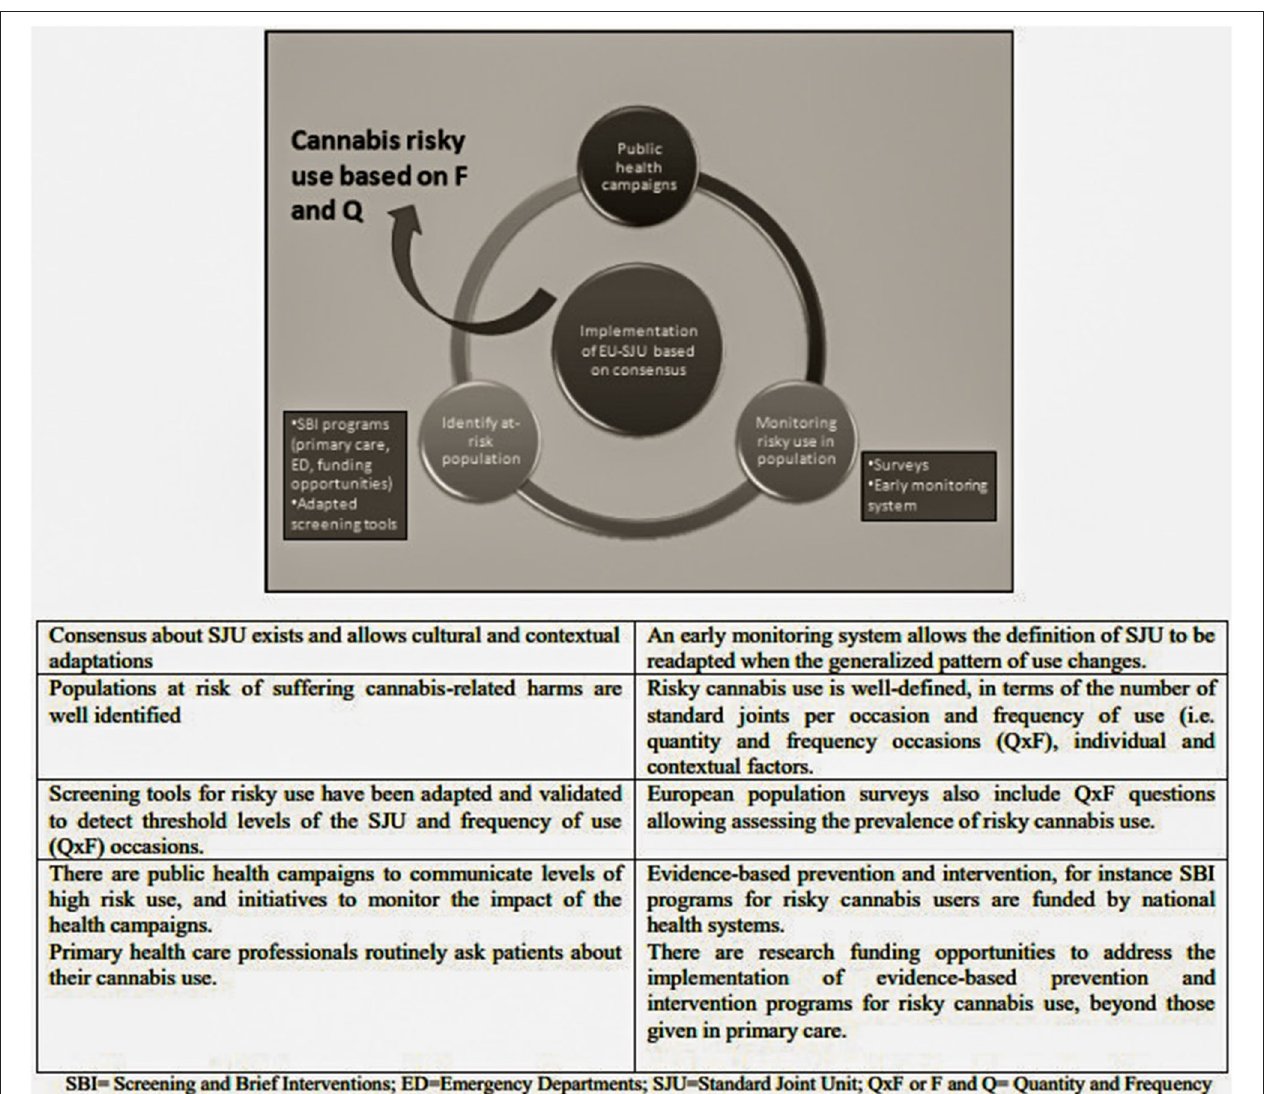
FIGURE 1 | Hypothetical desirable future in 2030, used to guide the back-casting